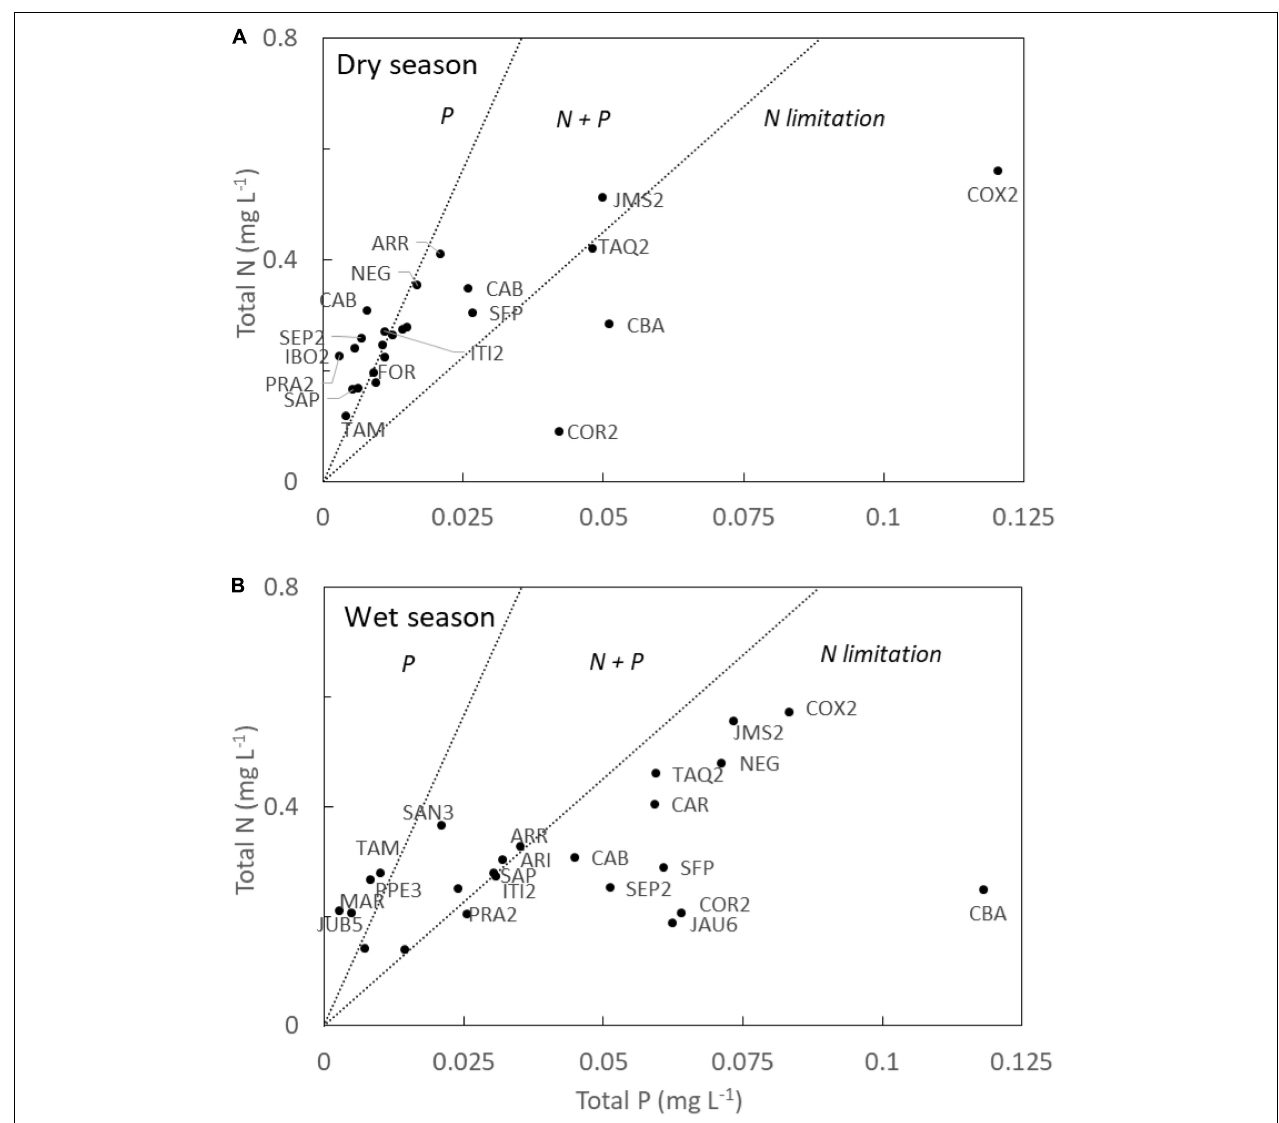
FIGURE 2 | Concentrations of TN and TP in rivers draining to the Pantanal with dashed lines delimiting the zone of likely co-limitation by N and P during the dry season (A) and wet season (B) . In reaches containing hydropower facilities (13 of the 24 locations), the data shown here are downstream of the facilities. Observations were divided into seasons based on mean monthly rainfall, with May-October and November-April as the dry and wet seasons, respectively. Codes indicate the sampling points detailed in Table 1 . The figure includes both primary and secondary data and reaches with current hydropower facilities as well as reaches targeted for future facilities.